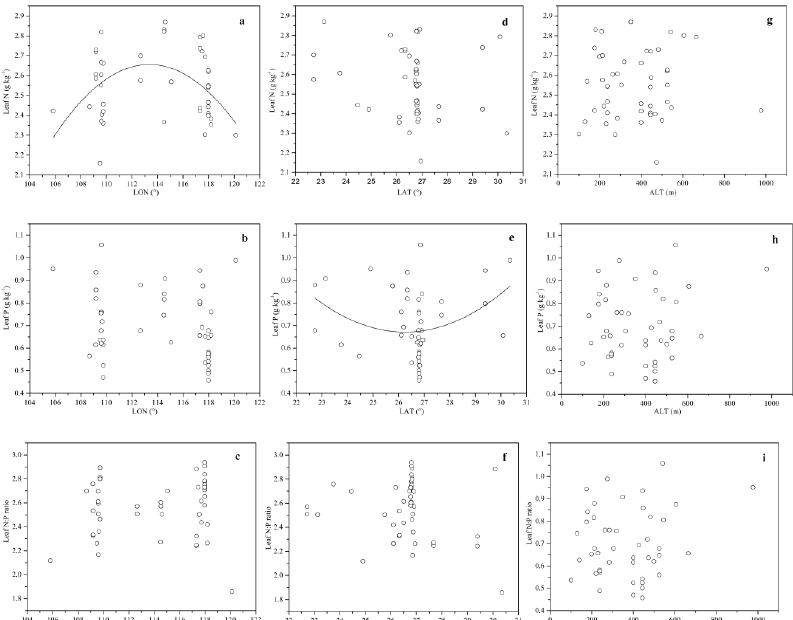
Figure 3. Relationships between the leaf stoichiometry and geographical factors for Chinese fir. Each data point represents an ln (N + 1)-transformed leaf N or P concentration or leaf N:P ratio. Quadratic fit for ( a ) the leaf N and LON (Longitude) ( R 2 = 0.11, p < 0.05); and ( e ) the leaf P and LAT (Latitude) ( R 2 = 0.09, p < 0.05). No fit for ( b ) the leaf P and LON; ( c ) the leaf N:P ratio and LON; ( d ) the leaf N and LAT; ( f ) the leaf N:P ratio and LAT; ( g ) the leaf N and ALT; ( h ) the leaf P and ALT; and ( i ) the leaf N:P ratio and ALT.